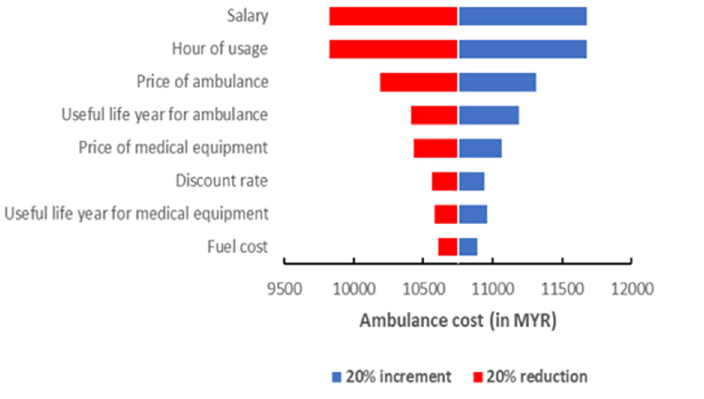
Fig 3. One-way sensitivity analysis tornado chart.